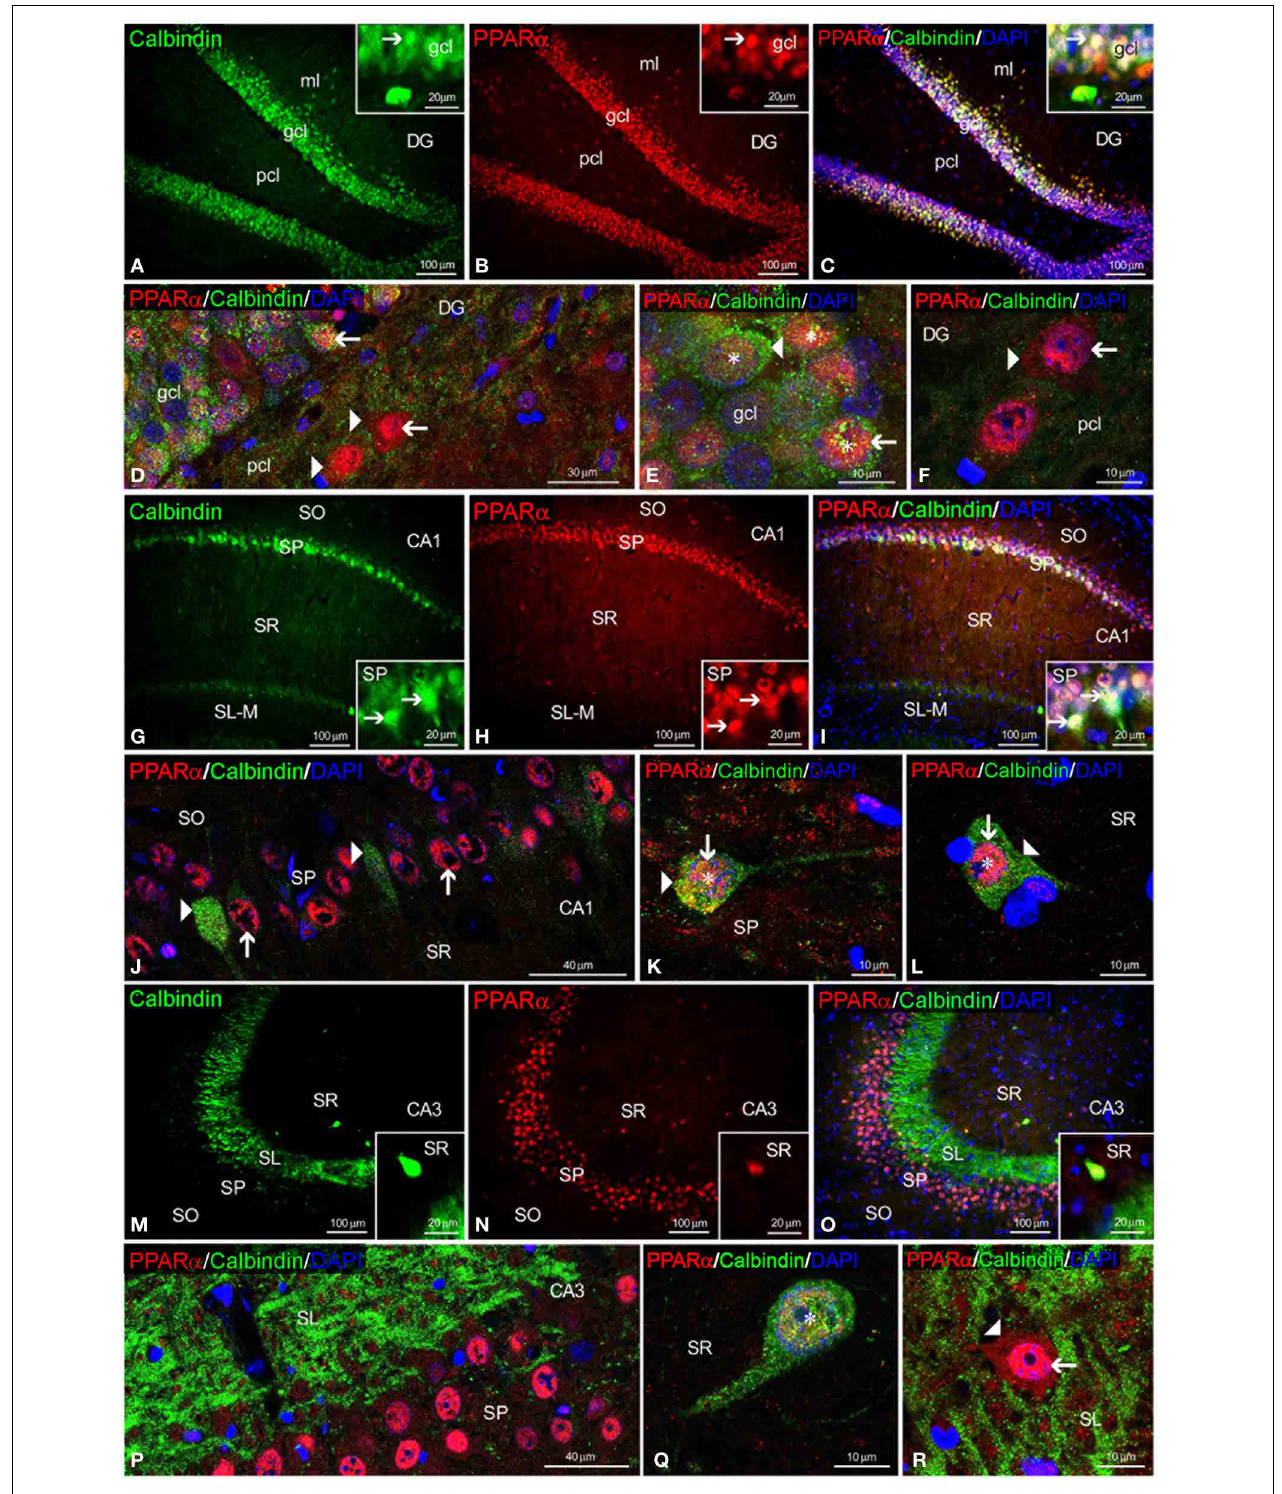
FIGURE 3 | PPAR α and calbindin co-expression in the rat hippocampus. Low-resolution epifluorescence photomicrographs (A–C,G–I,M–O) and high-resolution confocal laser scanning photomicrographs (D–F,J–L,P–R) showing the immunoreactivity of calbindin (green) and PPAR α (red) in the dentate gyrus (DG), CA1, and CA3 areas. DAPI fluorescence (blue) was used